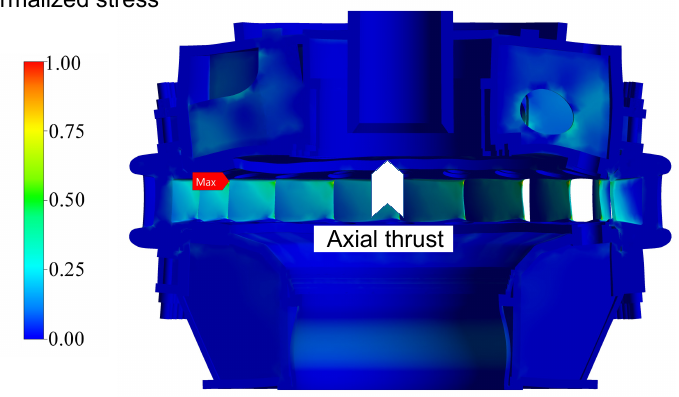
Figure 15. The flow-induced stress of the non-rotating structures. The stress distributions of the stay ring, bottom ring and head cover shown in Figures 16–18 are normalized by their respective maximum stress